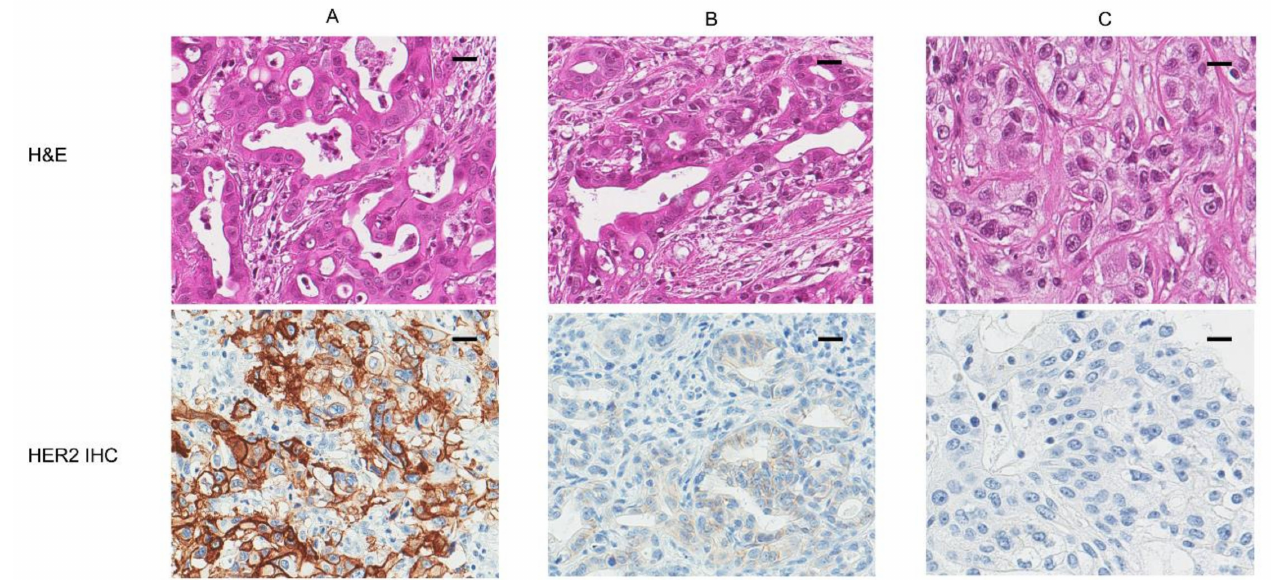
Figure 1. Representative examples of human epidermal growth factor receptor2 (HER2) protein. ( A ) A pancreatic adenocar- cinoma showed overexpression of HER2 protein. ( B ) A pancreatic adenocarcinoma showed low expression of HER2 protein. ( C ) A pancreatic adenocarcinoma showed a negative expression ( × 200; scale bar, 50 µ